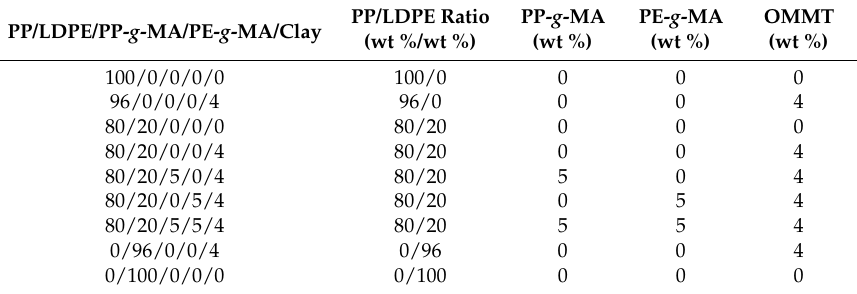
Table 1. Compositions of the extruded